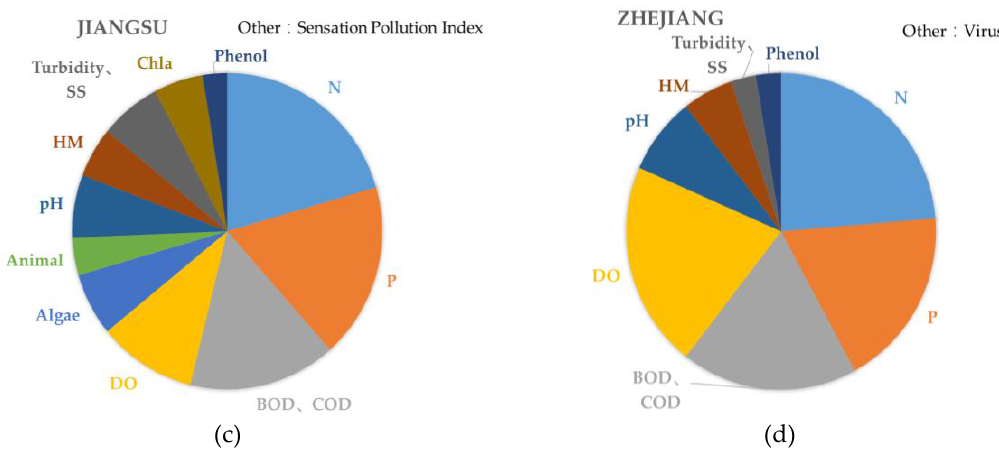
Figure 6. Water quality parameters assessed in four major cities and provinces of China. ( a ) Beijing, ( b ) Shanghai, ( c ) Jiangsu, ( d )Zhejiang.